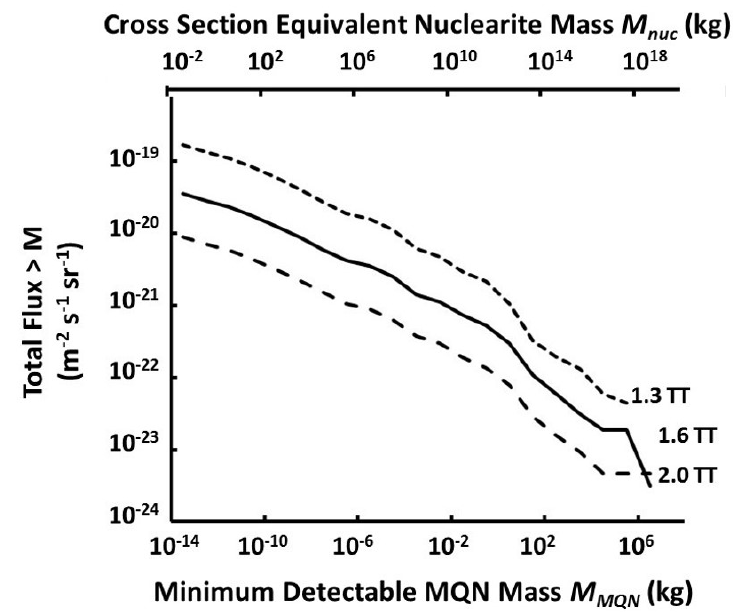
Figure 1. The integral of the MQN number density from minimum detectable MQN mass M MQN to infinity times 230 km/s, the velocity of the solar system through the galactic halo, gives the predicted number flux for mass ≥ M MQN plotted on the x -axis for range of currently allowed values of B o . For B o = 1.65 × 10 12 T and atmospheric mass density (~10 − 3 kg/m 3 ) at the 50 km altitude to be probed for nuclearites by JEM-EUSO, the nuclearite mass M nuc with the same interaction cross section as M MQN is plotted above the graph.